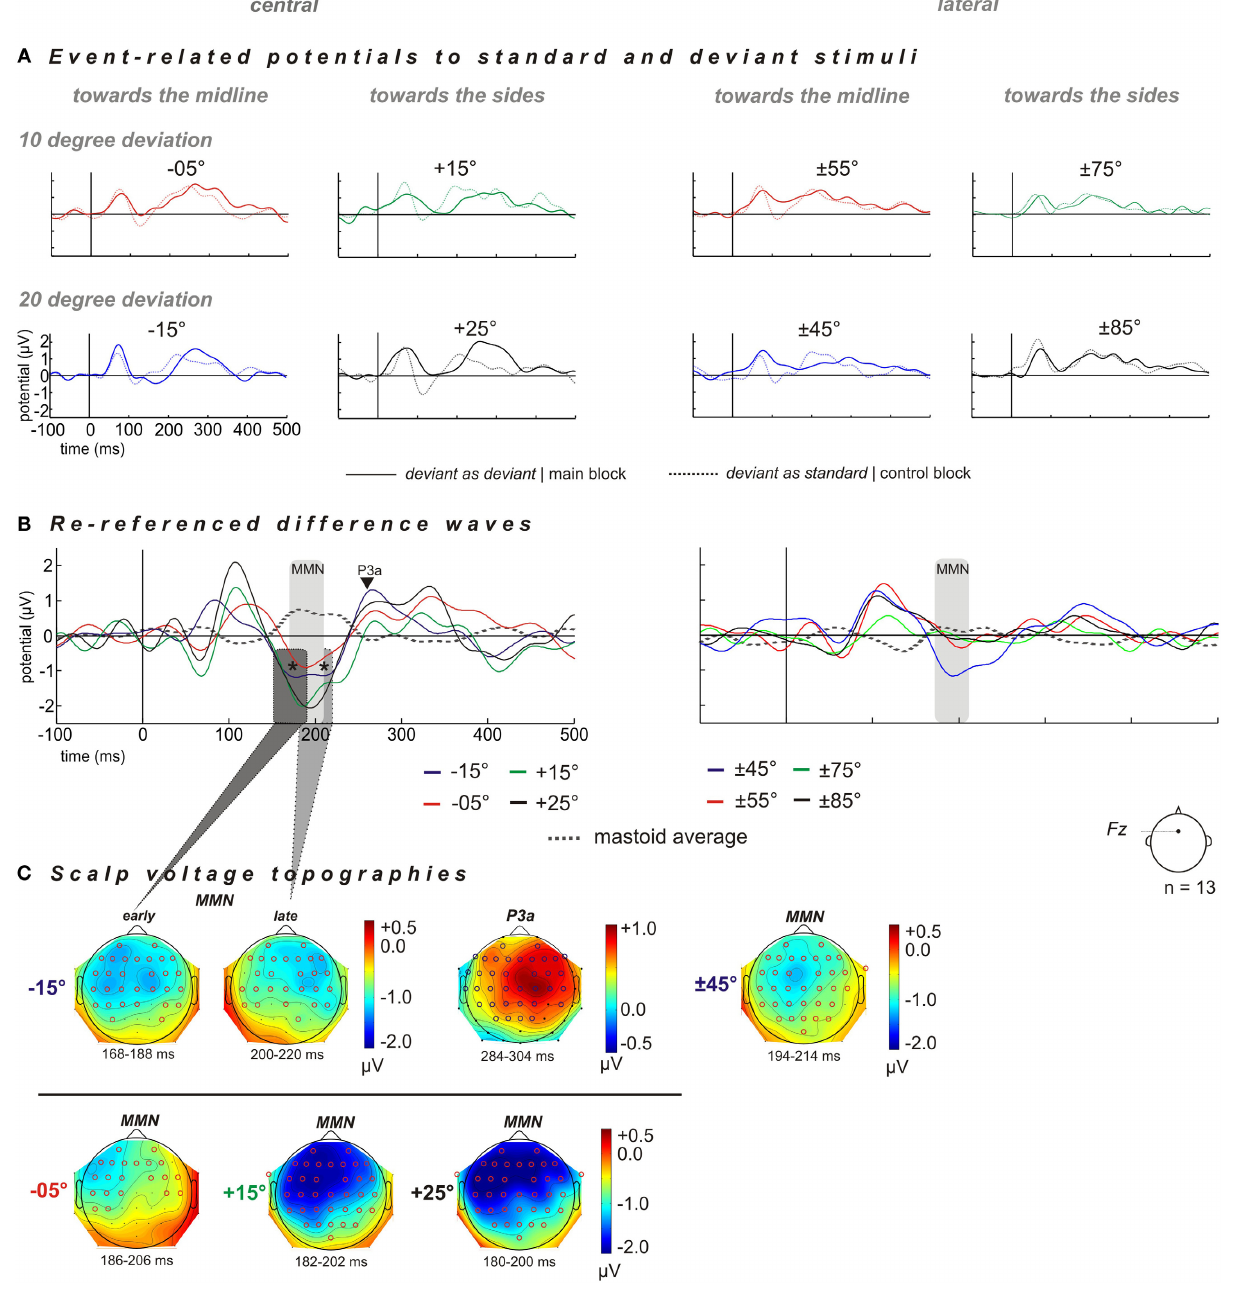
(solid lines) re-referenced to ERP signal obtained at mastoid electrodes (dashed gray lines). For the condition “central” all deviants elicited sizeable MMN responses. Deviant position − 15 ◦ evoked a two-tailed MMN component, i.e., early and late MMN components within a time window of 168–188ms and 200–220ms, respectively (indicated by asterisks), followed by a P3a component in the time window of 285–205ms after stimulus onset. For the condition “lateral,” only the deviant position at ± 45 ◦ elicited sizeable MMN responses. (C) Scalp voltage topographies of the MMN and P3a amplitudes for respective deviant positions, significant electrodes sites were shown as red and blue circles (one-sample, one-sided t -test, p < 0 . 05) n =